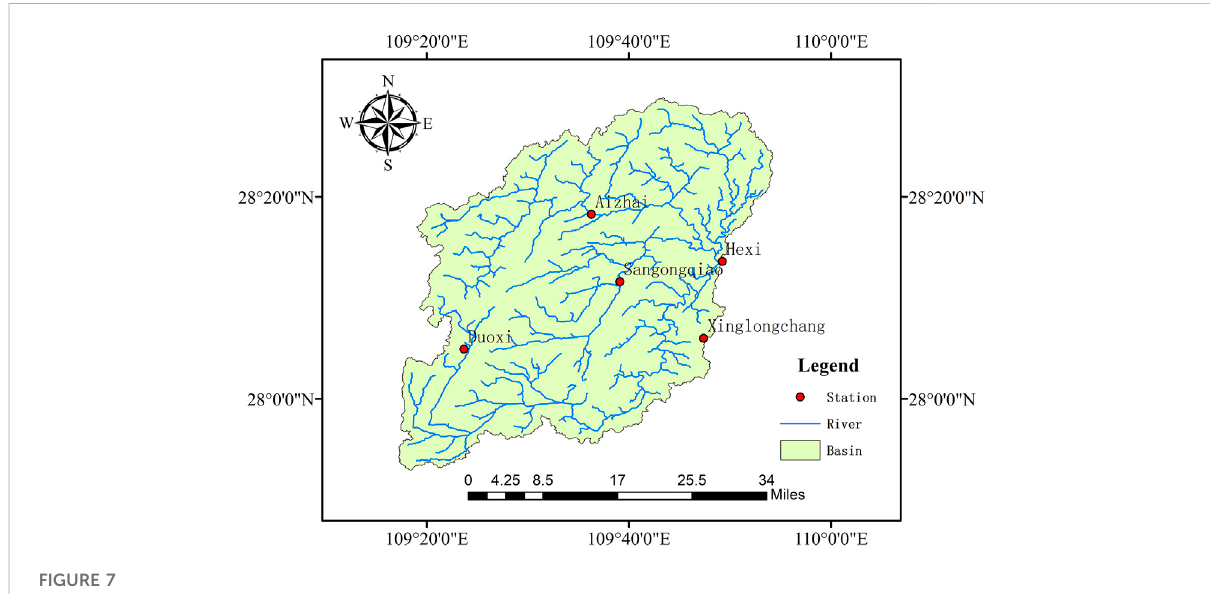
FIGURE 7 Study area and station